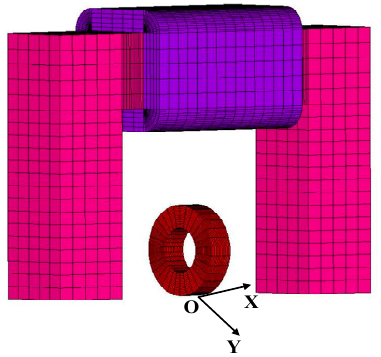
Figure 11. ACSM probe 3D simulation model.